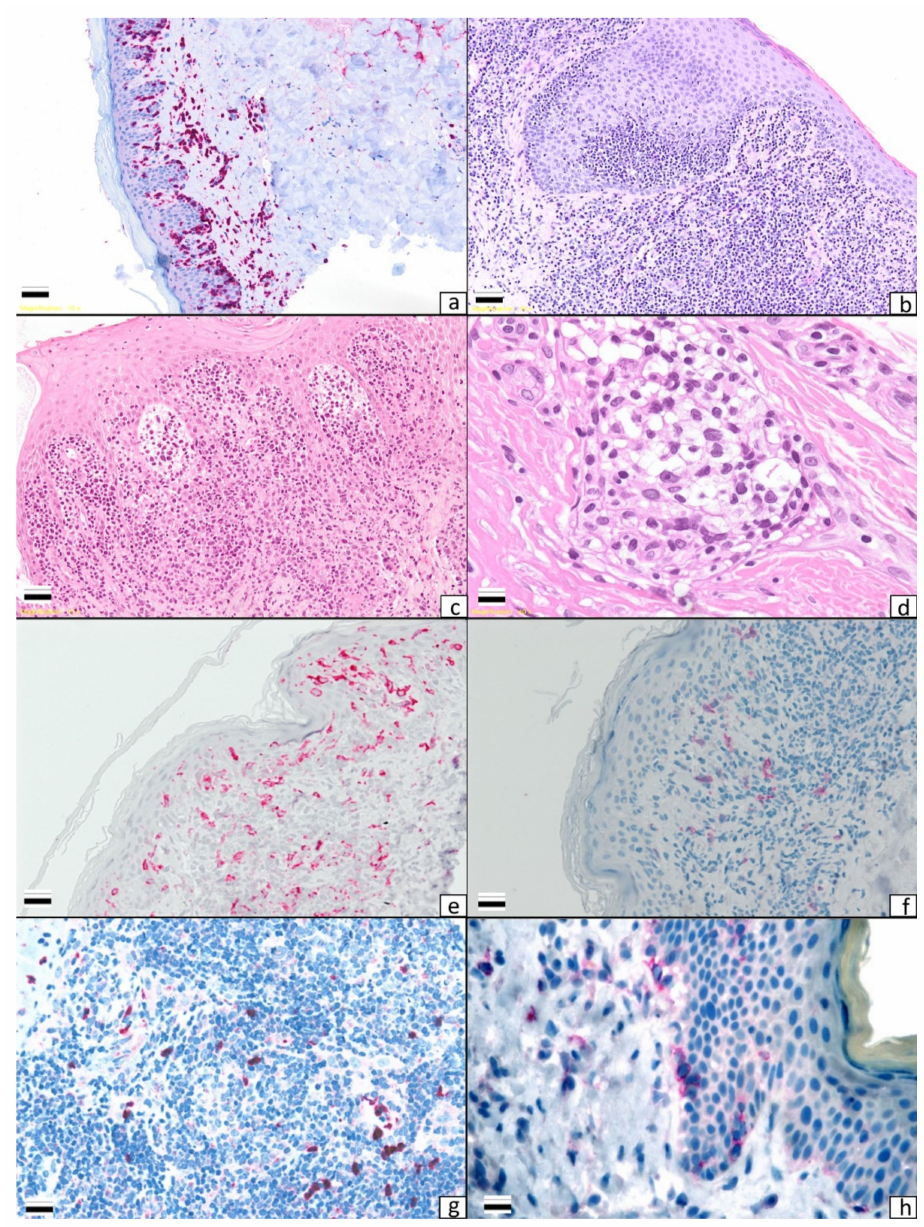
Figure 2. Different histological patterns in mycosis fungoides: ( a ) patch stage ( × 10), ( b ) plaque stage ( × 10), ( c ) tumor stage ( × 10), ( d ) Sezary cells within a blood vessel in a Sezary syndrome patient ( × 40), ( e ) a high number of Langerin-positive cells in an early stage of mycosis fungoides ( × 10), ( f ) CD303-positive cells in the plaque stage of mycosis fungoides ( × 10), ( g ) a high number of myeloid-derived suppressor cells (Arginase+) in the tumor stage of mycosis fungoides ( × 10), ( h ) a high number of VEGF-A-positive cells in a patch stage case ( ×